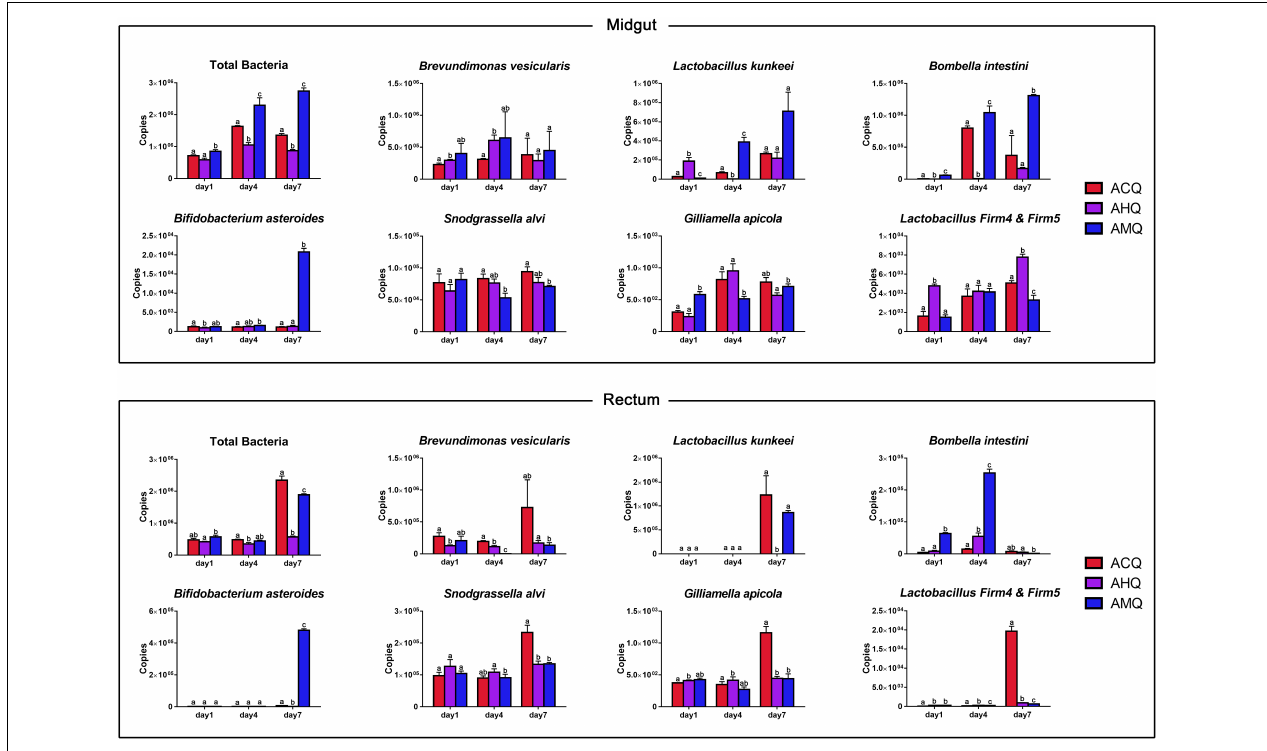
FIGURE 5 | Changes of core members’ absolute abundance in queens’ early developmental stage (1, 4, and 7 days) measured as copies of the 16S rRNA gene. The columns of host groups were differently colored in red for ACQs, violet for AHQs, and blue for AMQs. Letters above confidence intervals (1 standard deviation) represent significance levels (Tukey’s